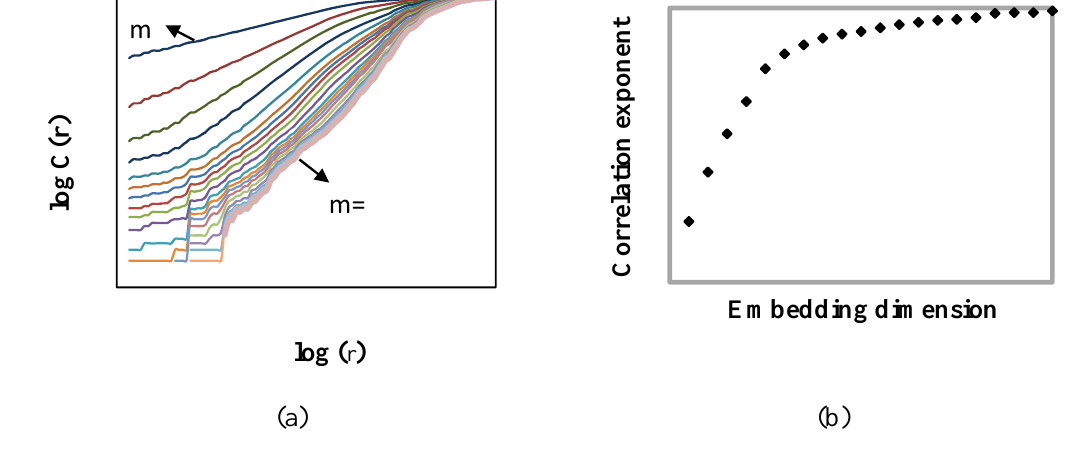
Fig.8 Results of AFC: (a) Log C(r) Versus Log(r) for m= 1-20; (b) Log C(r) versus Log(r) for m=1-20 Results by Local Prediction and ANFIS